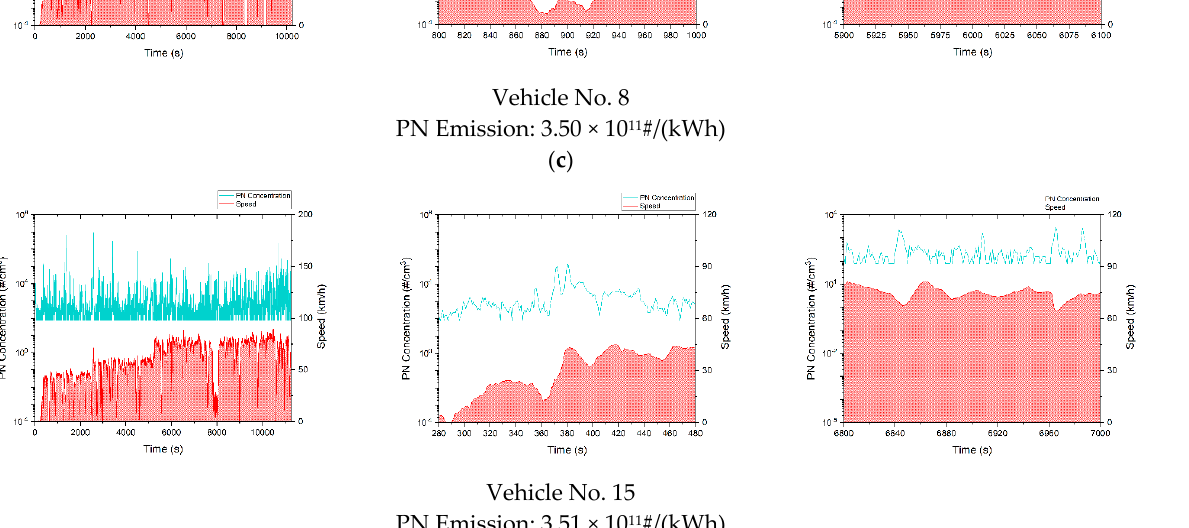
Figure A1. The relationship between the PN concentration and speed over time of a typical test vehicle. ( a ) China-5 diesel vehicle; ( b ) China-6 diesel vehicles with malfunctioning DPFs; ( c ) China- 6 diesel vehicles with intact DPFs; ( d ) China-6 NG vehicles. Figure A2 shows the instantaneous work-based PN emission and vehicle speed as a function of time for the four selected test vehicles. The dotted line in Figure A2 is the PN- PEMS cap (1.2×10 12 #/kWh). It is obvious that, for China-5 diesel vehicles and China-6 die- sel vehicles with malfunctioning DPFs, the instantaneous PN emissions during most of the testing duration were in the range of 10 12 ~10 15 #/kWh, the fluctuations were more pro- nounced than the normal vehicles, and the idle PN emissions were also relatively high; The instantaneous PN emission rate of China-6 diesel vehicles with intact DPFs and China-6 NG vehicles were below the WHTC limit of 1.2 × 10 12 #/kWh during most of the testing duration, which were 3~4 orders of magnitudes lower than China-5 diesel vehicles; in addition, their idle PN emissions were low. According to Figures A1 and A2, for vehicles without DPFs or with malfunctioning DPFs, in the vehicle starting period, the PN emissions grew with the acceleration of the vehicles. It was also observed that PN emission decreased as the test vehicle decelerated. However, for vehicles with intact DPFs, PN emissions showed no clear correlation with acceleration or deceleration. In a constant speed state, there was no clear relationship be- tween PN emission and vehicle speed.